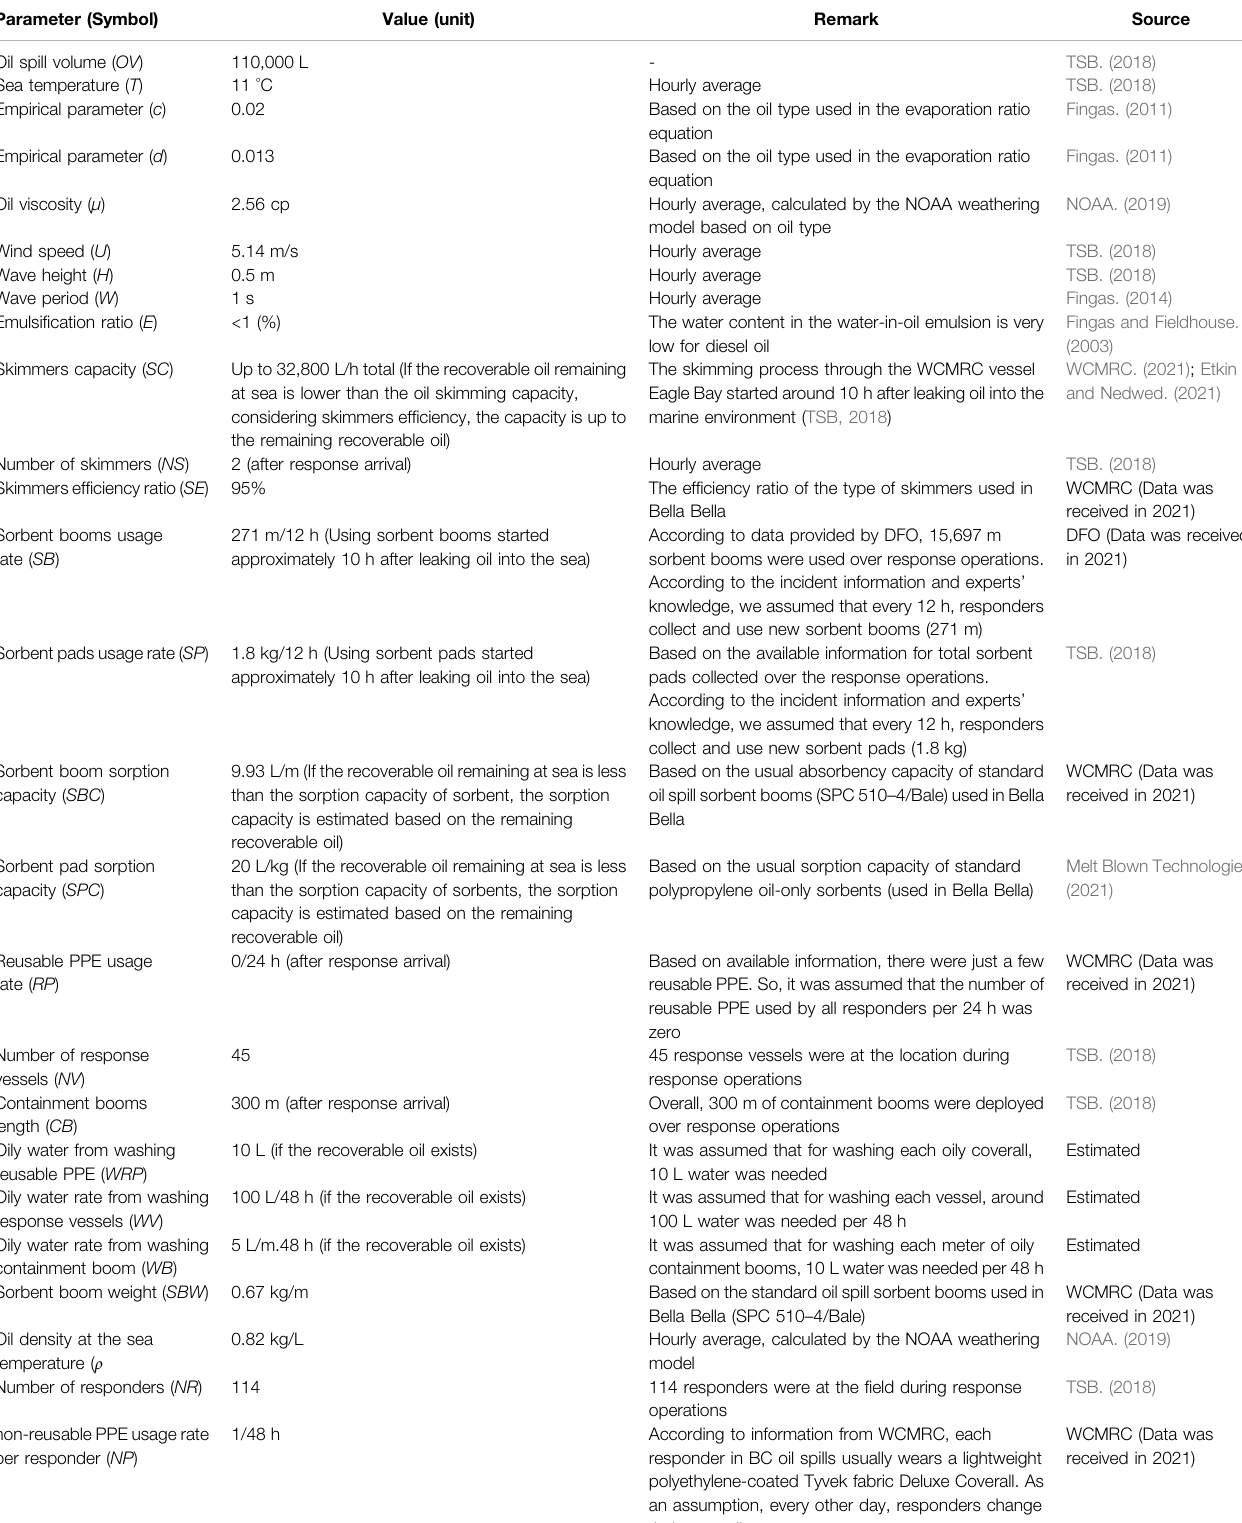
TABLE 2 | Bella Bella oil spill data and assumptions for the system dynamics model